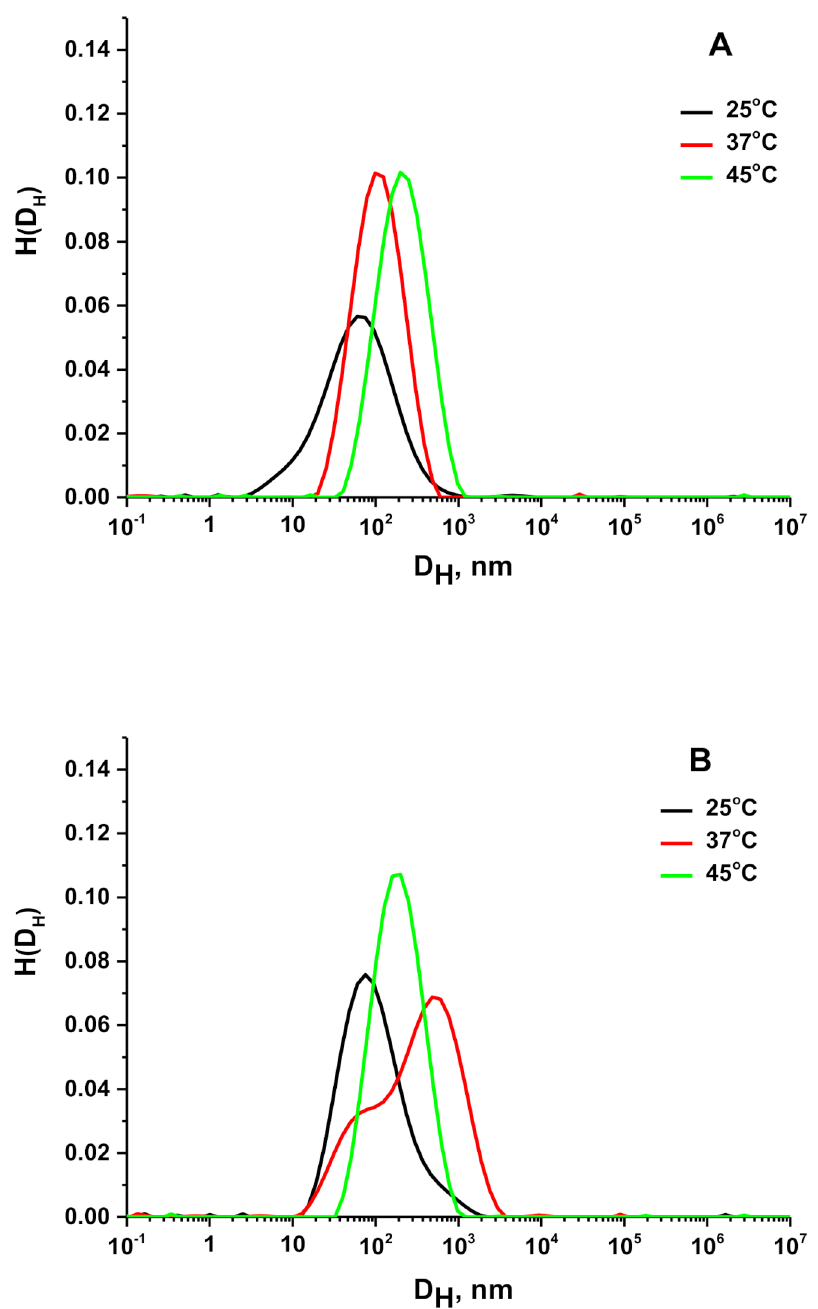
Figure 3. Hydrodynamic diameter distributions for D-g-PNIPAM ( A ) and D-g-PNIPAM + Dox system ( B ) at different